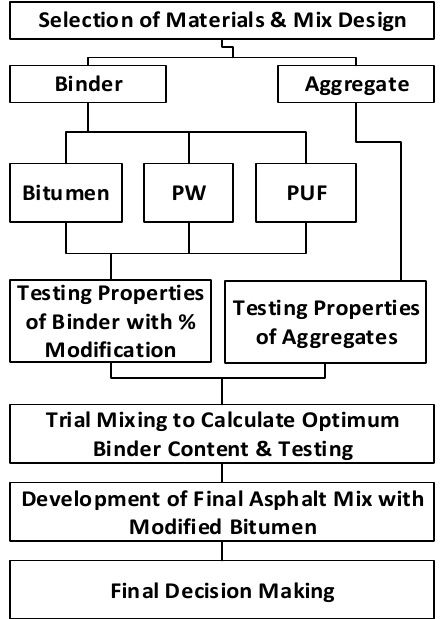
Figure 1. Research framework.